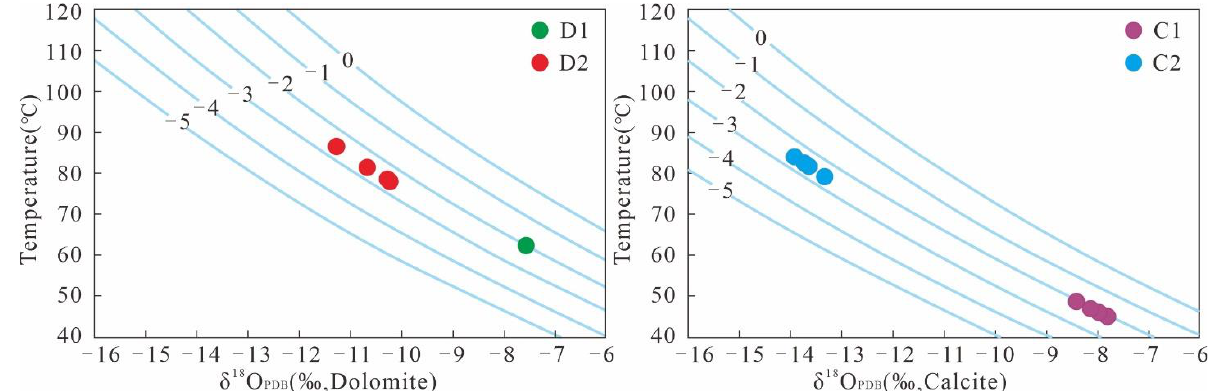
Figure 7. The geological temperature of the isotopes of calcite and dolomite; D1, D2, C1, and C2 represent early dolomite, ferrodolomite, ferrocalcite, and late calcite, respectively.